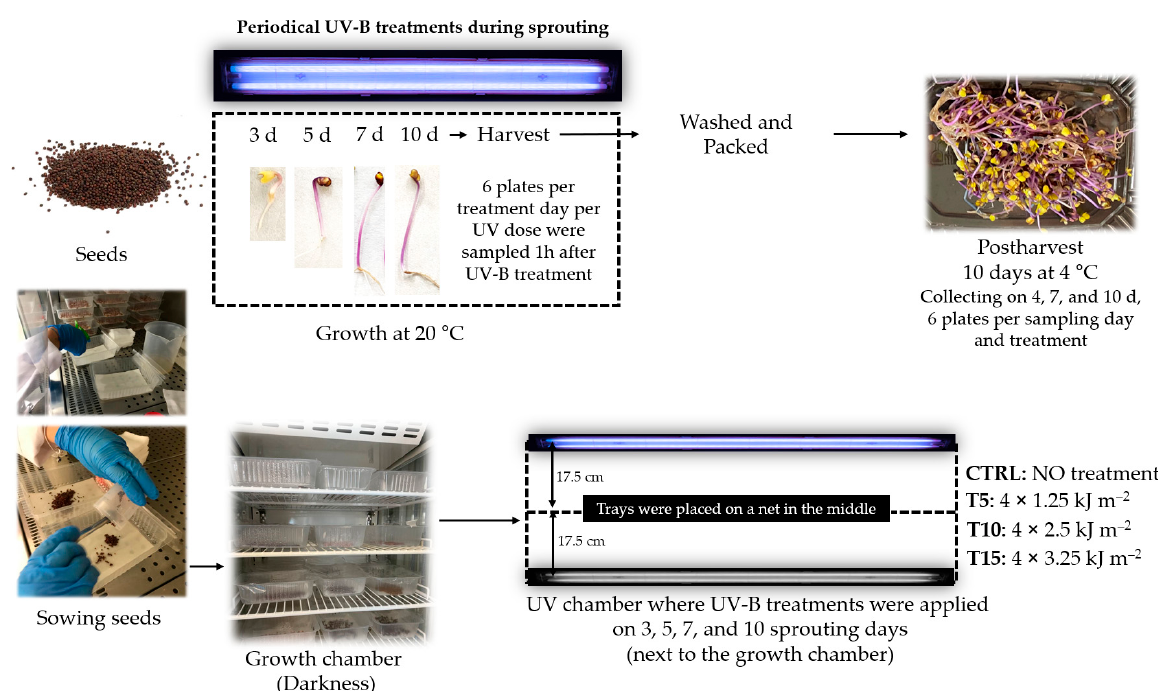
Figure 1. Experimental design evaluating the effect of periodical UV-B illumination on the physiology of red cabbage spouts and the content of bioactive compounds (phenolics, flavonoids, and carotenoids) both during germination and during cold storage. Seedlings received 5, 10, or 15 kJ m − 2 UV-B (T5, T10, and T15) divided into four doses applied on 3, 5, 7 and 10 days of the sprouting period (10 days at 20 ◦ C in darkness). UV-untreated sprouts were used as control (CTRL). At the end of the germination (10 days), the sprouts were harvested and stored 10 days at 4 ◦ C. Sprout development and studied bioactive compounds were analysed after 1 h of each UV-B application (sprouting period) and on 0, 4, 7, and 10 days at 4 ◦ C (shelf-life